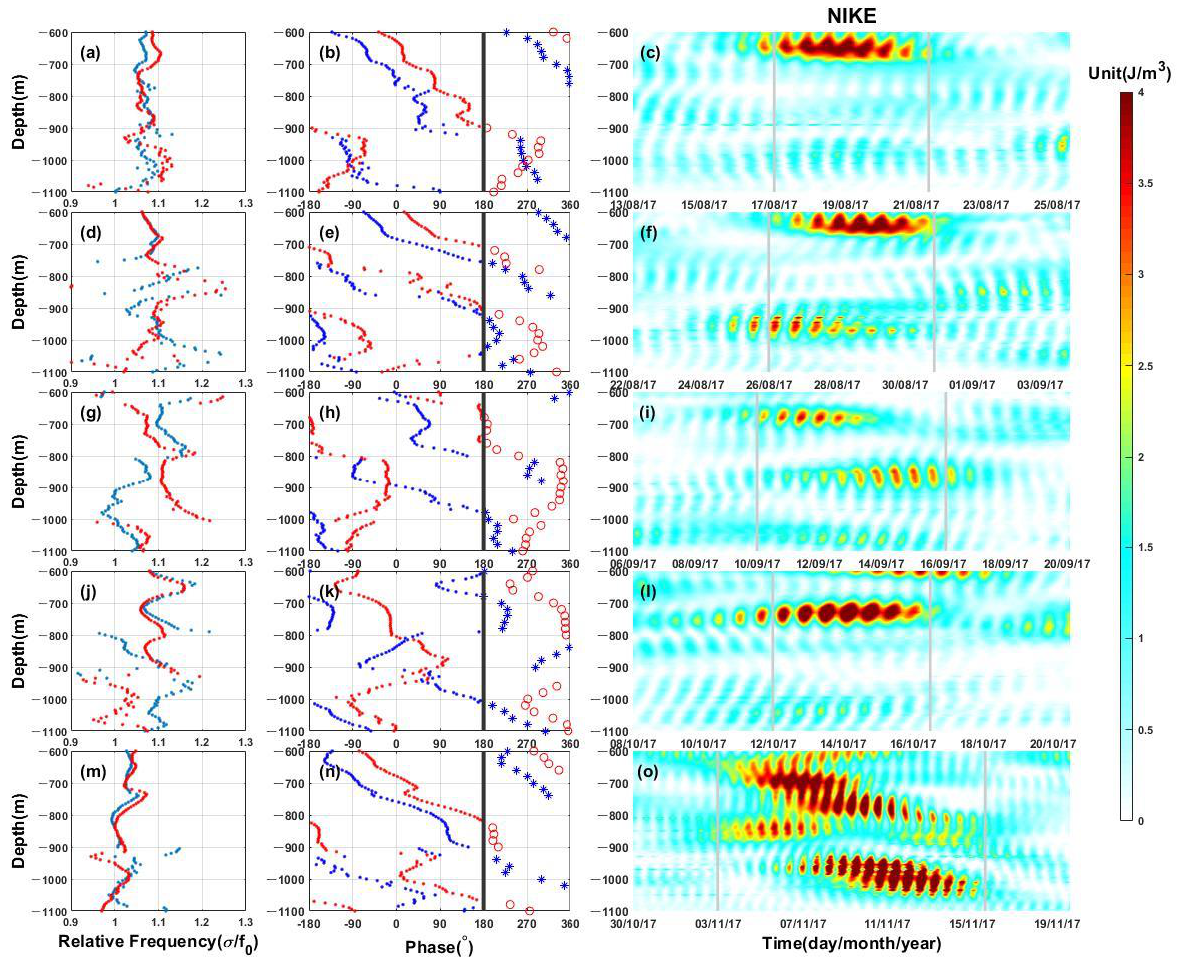
Figure 4. ( a , d , g , j , m ) The depth distribution of the frequency for NA, NB, NC, ND, and NE. ( b , e , h , k , n ) The depth distribution of the phase for NA, NB, NC, ND, and NE. ( c , f , i , l , o ) Depth–time map of the NIKE for NA, NB, NC, ND, and NE. The blue points indicate the zonal velocity (U) result, and the red points indicate the meridional velocity (V) result. Color bar units are J m − 3 . To better discover the depth change in the phase, we drew a mark for the part from − 180 ◦ to 0 ◦ a second time and placed it between 180 ◦ and 360 ◦ using asterisks and circles.